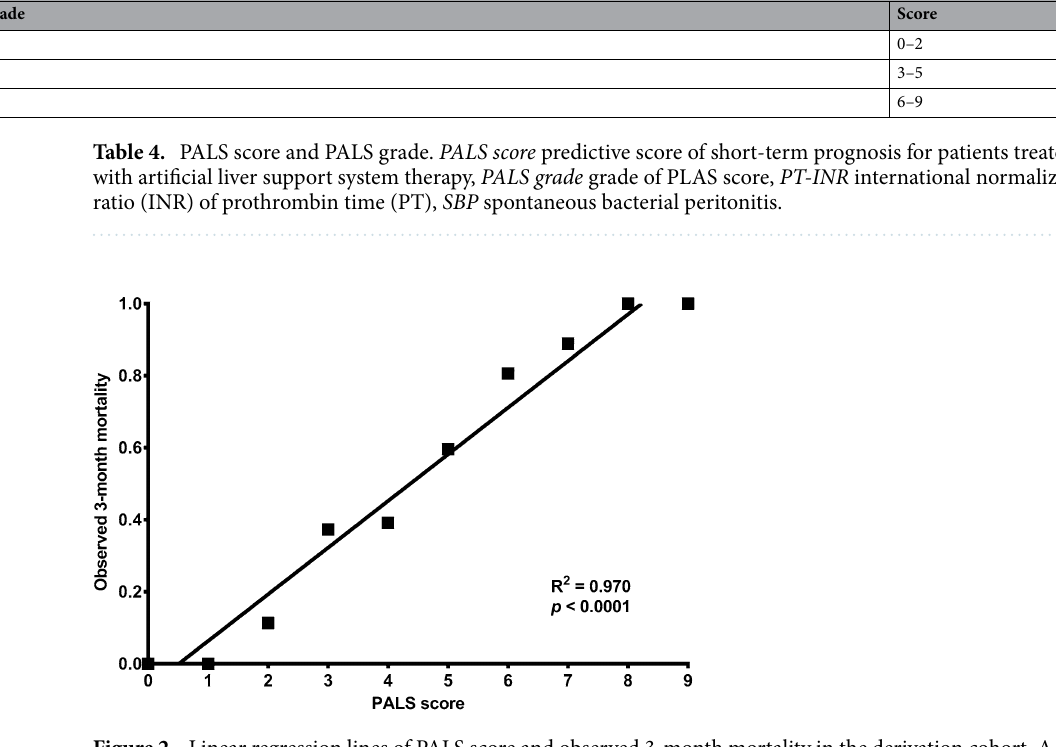
Figure 2. Linear regression lines of PALS score and observed 3-month mortality in the derivation cohort. A linear regression equation was developed for the PALS score and 3-month mortality in derivation: 3-month mortality = 13.0% × PALS score − 6.6%. PALS score predictive score of short-term prognosis for patients treated with artificial liver support system